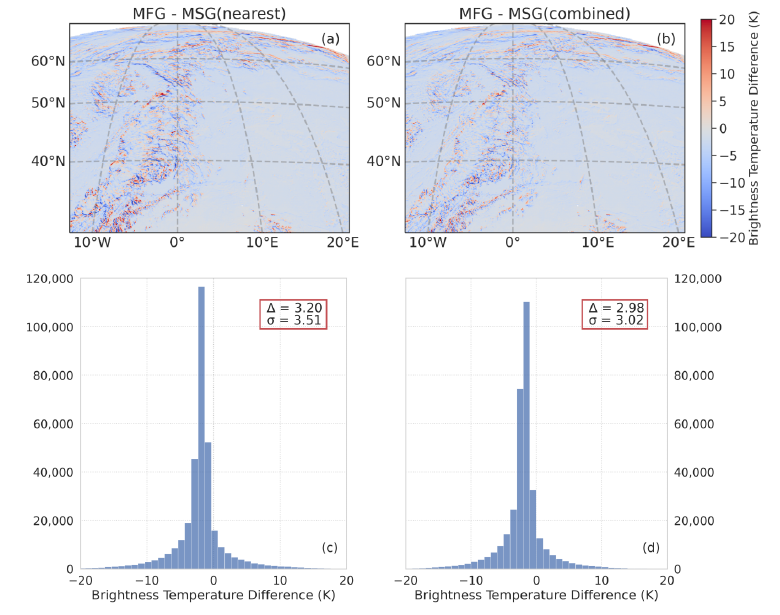
Figure A1. The difference plots of an exemplary ( a ) MFG IR original and the nearest MSG IR 10.8 µm scene, and ( b ) MFG IR original and two MSG IR10.8 µm scenes combined using our approach, along with the mean ( ∆ ) and the standard deviation ( σ ) values. Their respective histogram plots ( c , d ) are shown below in the figure. The exemplary scene belongs to a day with a moving cloud system over the study region (30 October 2005, 13:00–13:30